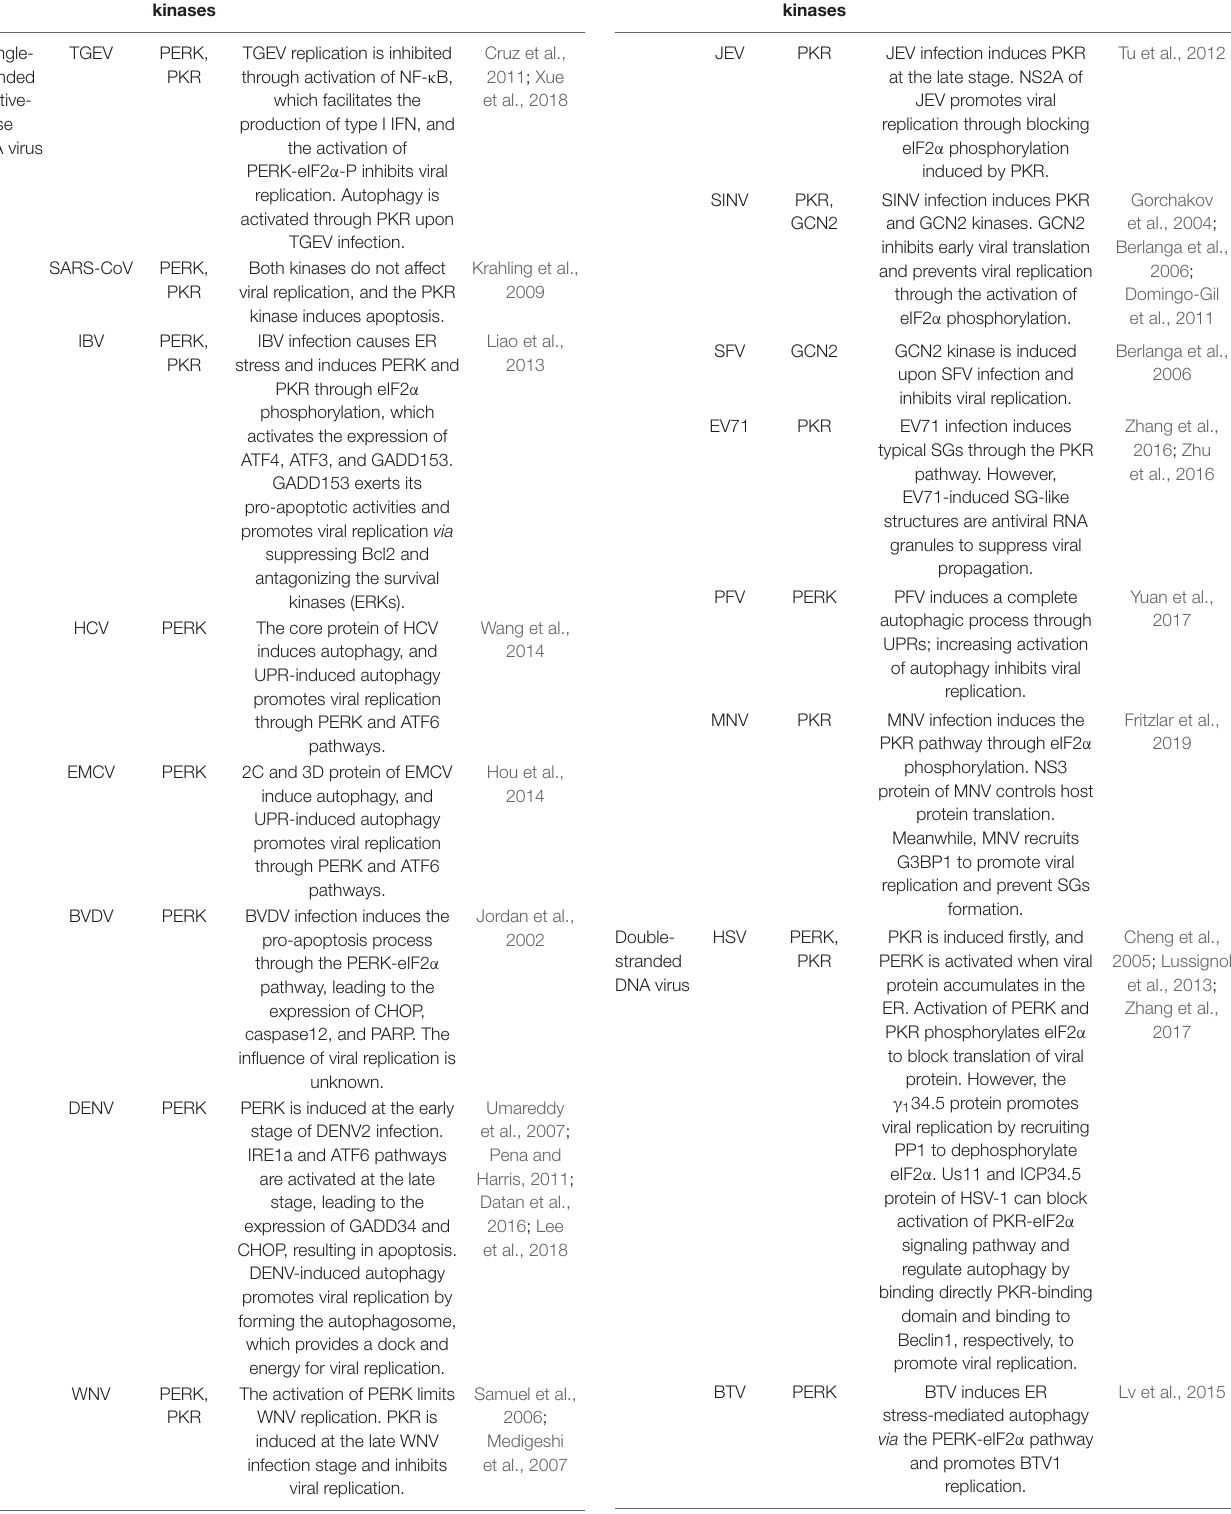
TABLE 1 | Activation mechanism of ISR signaling pathway upon viral